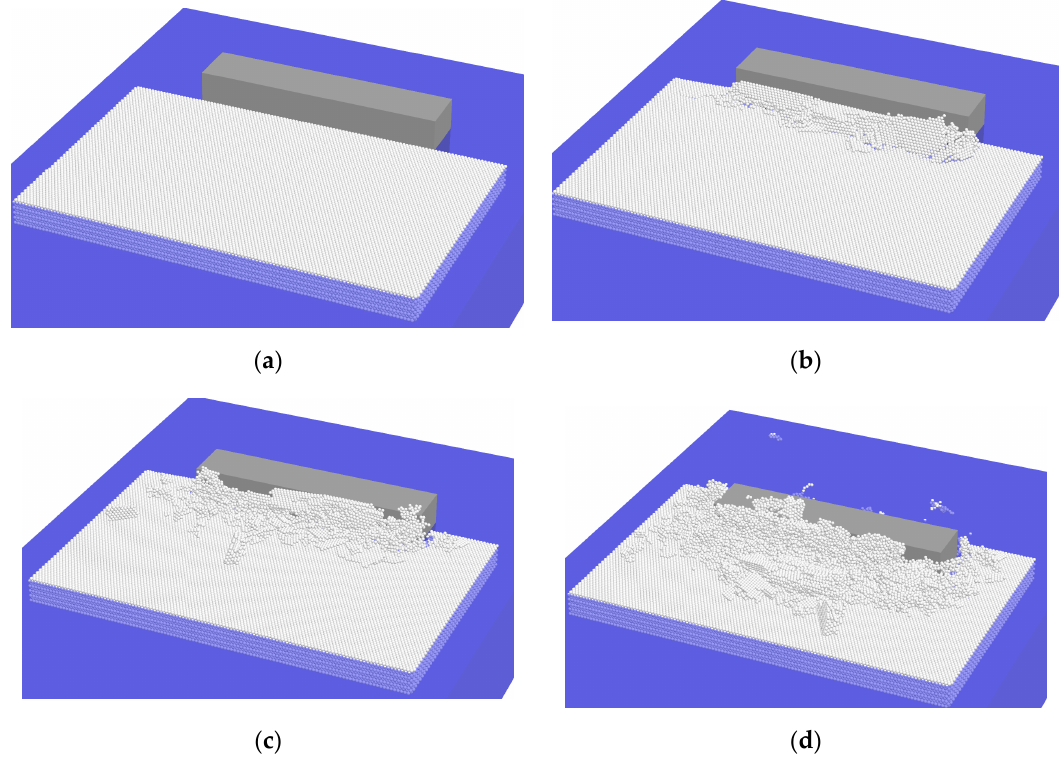
Figure 7. Failure process of the ice–structure interaction: ( a ) t = 0.0 s; ( b ) t = 20 s; ( c ) t = 60 s; ( d ) t = 160 s.